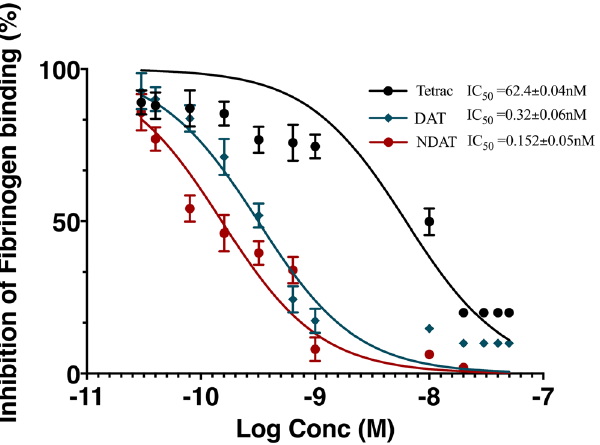
Figure 4. Binding affinity of tetrac, DAT, and NDAT to purified α v β 3. Error bars represent standard deviation of the mean, n = 3.